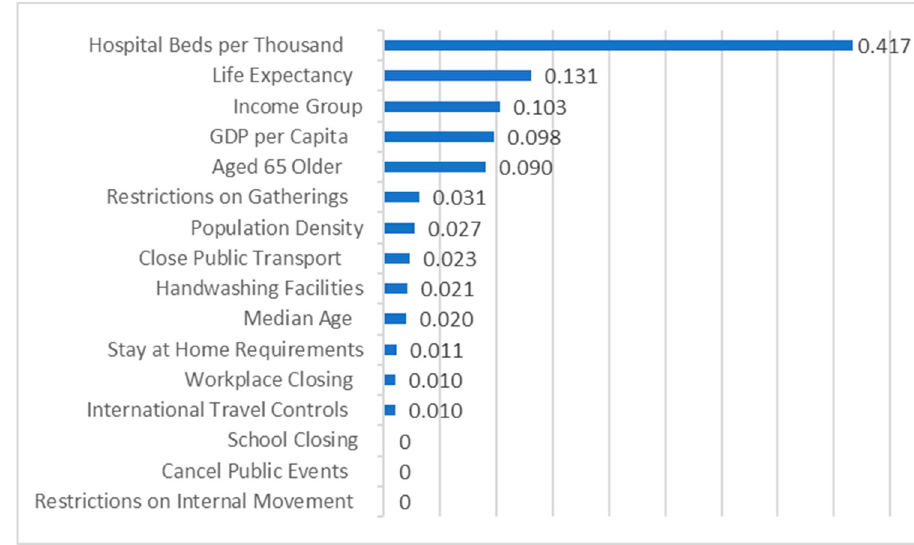
Figure 1. The relative importance of variables